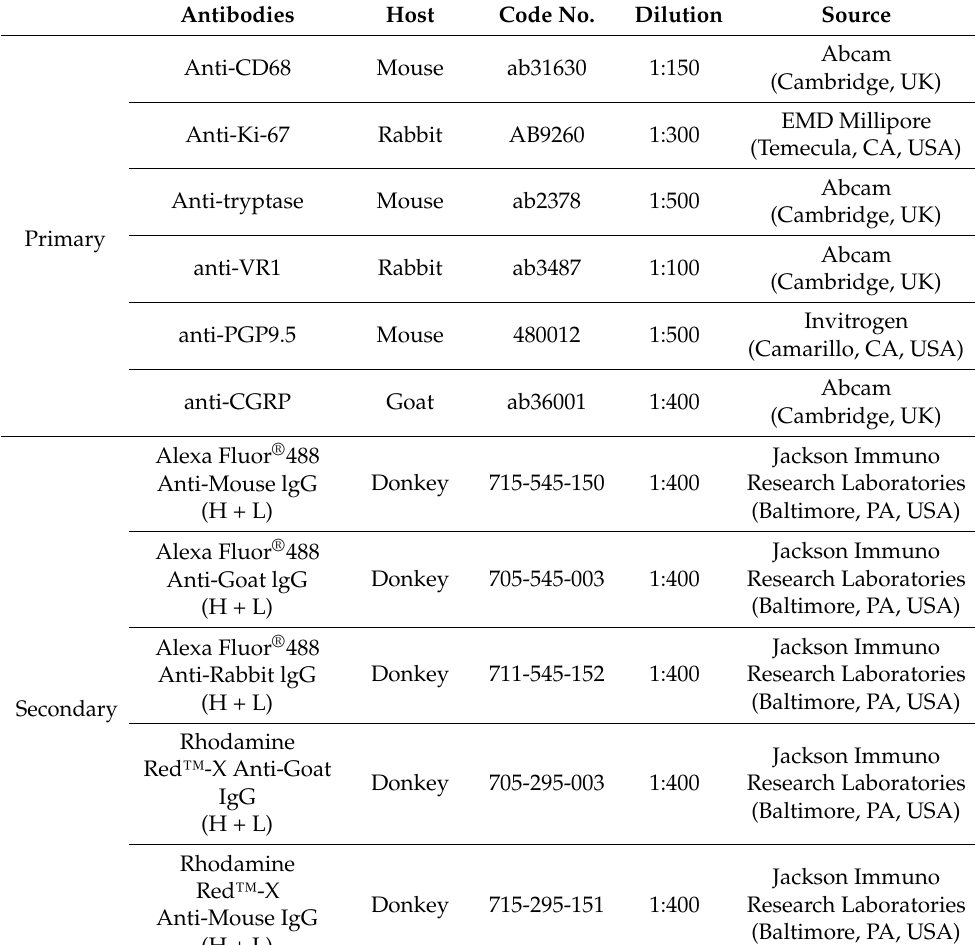
Table 1. Primary and secondary antibodies used in the